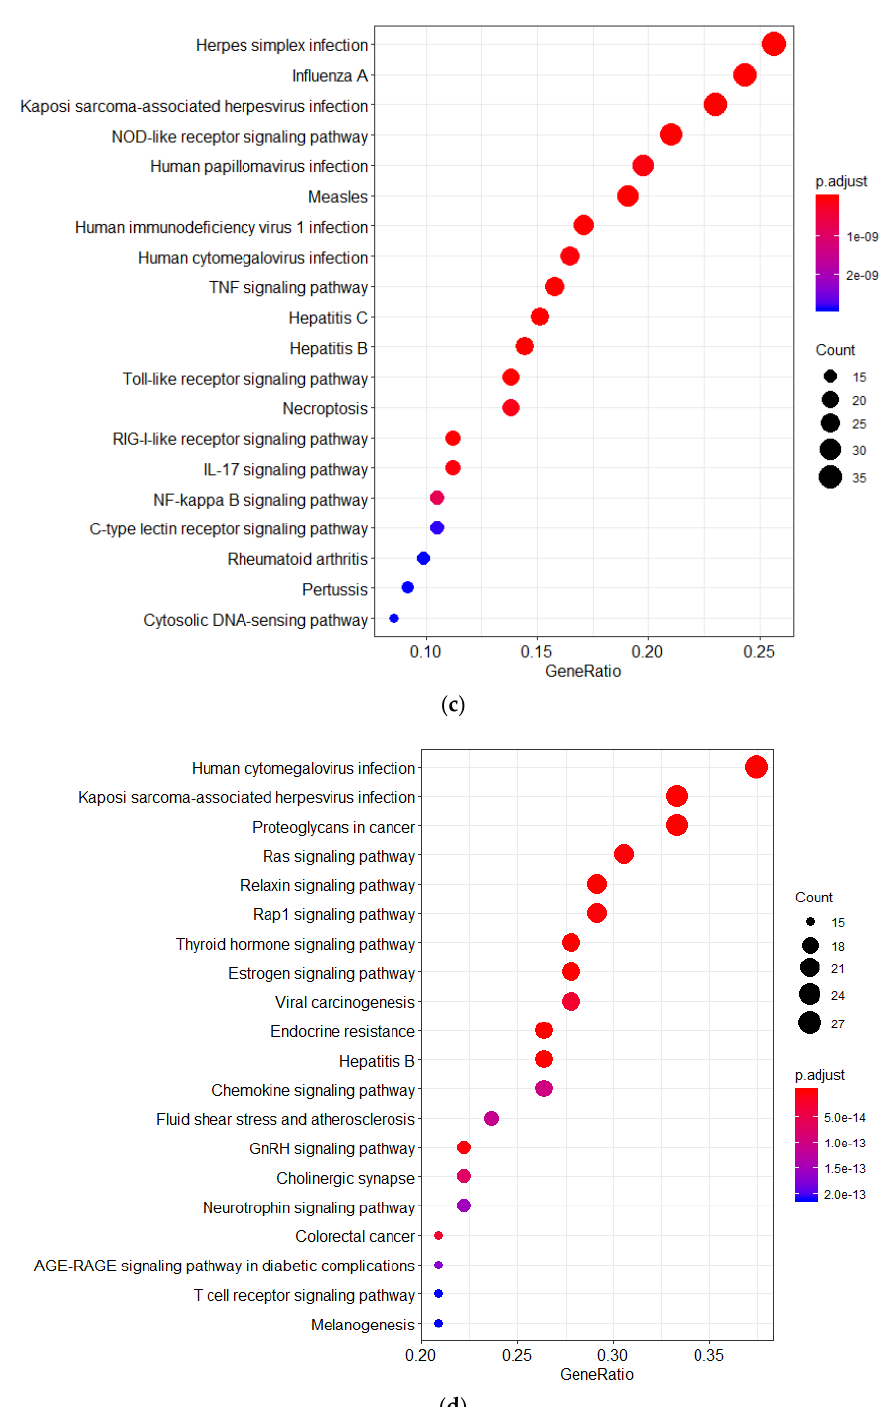
Figure 2. Functional characterization of the genes ranked by the GeneRank algorithm. Downregulated and upregulated genes that were ranked by the GeneRank algorithm were subjected to a GO enrichment analysis (biological processes) and a KEGG pathway enrichment analysis using the clusterProfiler package in R. The top 20 of the GO and pathways in that the up- and downregulated genes were significantly enriched, respectively ( p . adjust-value < 1 × 10 − 8 ) are presented. ( a ) GO enrichment analysis of upregulated genes; ( b ) GO enrichment analysis of downregulated genes; ( c ) KEGG pathway enrichment analysis of upregulated genes; ( d ) KEGG pathway enrichment analysis of downregulated genes.